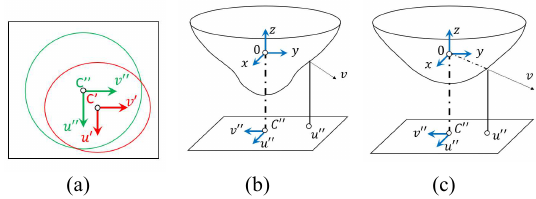
Figure 6 In (a) the sensor plane in metric coordinates (in green) and the overlapped camera image plane (in red). The two systems are related by an affine transformation. In (c) generic non-central